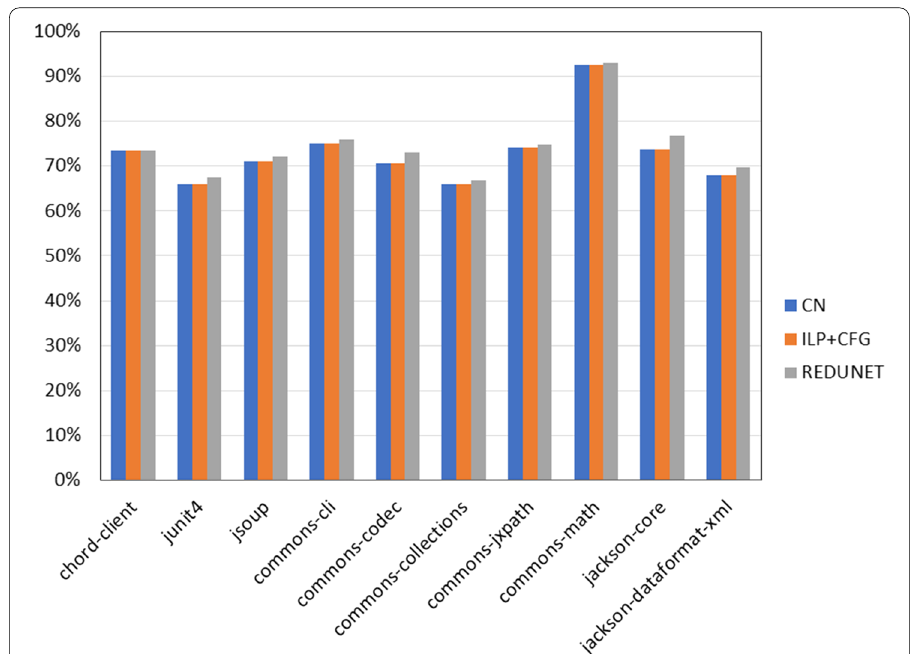
Fig. 8 Input size reduction. Percent of reduction of the input size for the ILP program ( y -axes). The labels in the x-axis represent the ten software projects under analysis, whose details are reported in Table 2. The series represents the approaches under comparison, whose details are given in Table